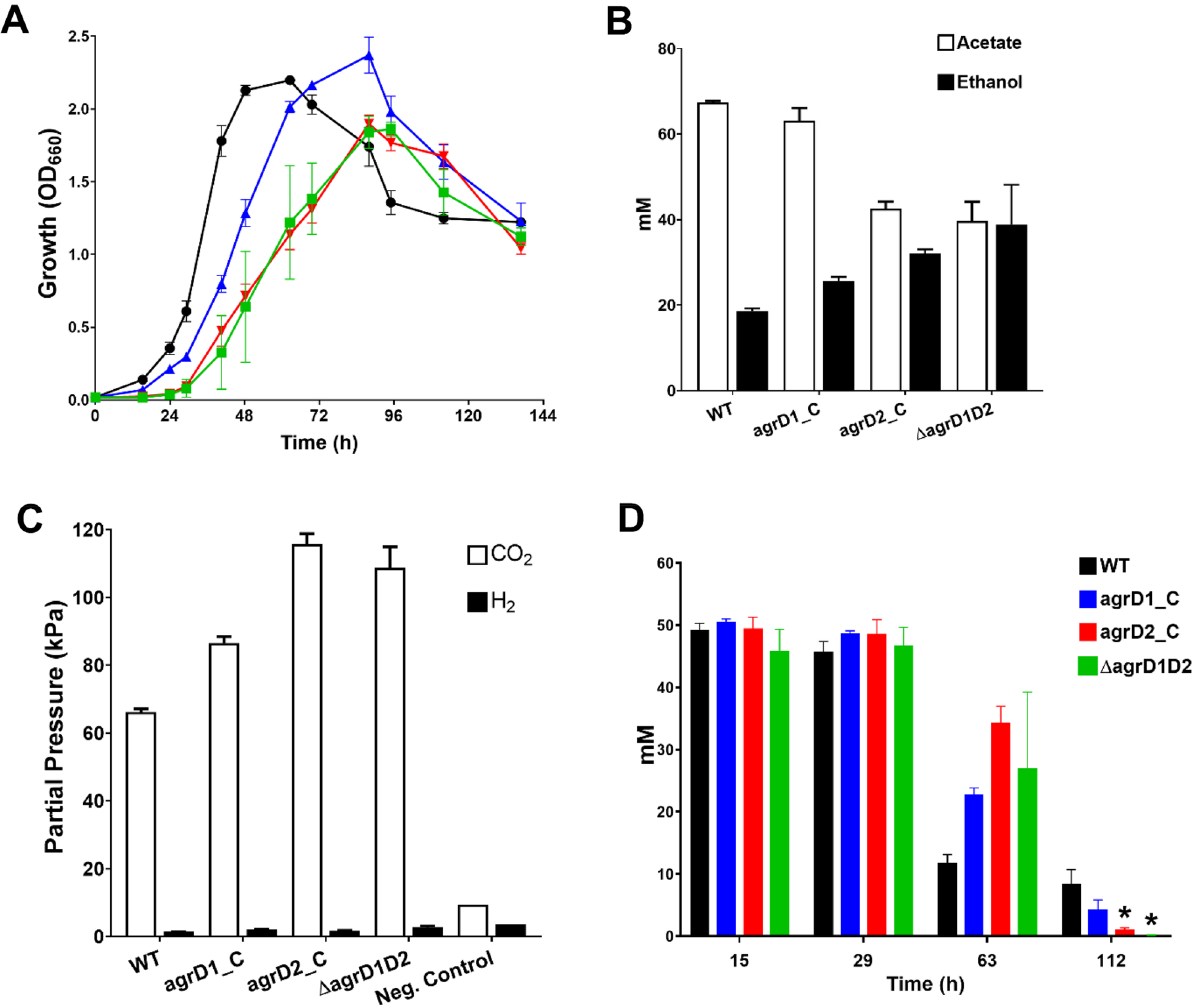
Figure 4. Growth, fermentation, and CO 2 pressure profiles of complemented agrD mutants revealing; ( A ) Growth profile, ( B ) acetate and ethanol production after 136 h, ( C ) CO 2 and H 2 pressures measured after 136 h and ( D ) fructose consumption. Black circles, WT (n = 3); Blue triangles, Δ agrD1D2 + D1comp (n = 3); Red inverted triangles, Δ agrD1D2 + D2comp (n = 3); Green squares, Δ agrD1D2 (n = 3). The negative control represented cultures without fructose addition. All error bars indicate standard error of the mean, P values equate to: * ≤ 0.05 of statistical difference to the